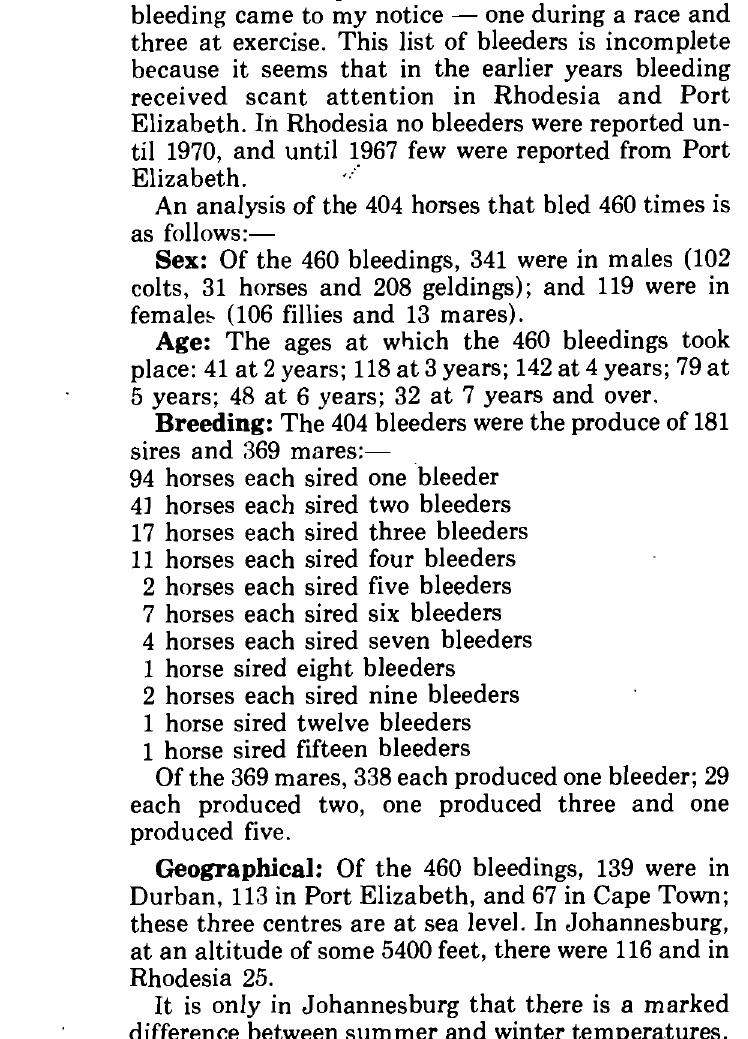
Table 1: DURATION OF SUSPENSION OF HORSE: DUE TO EPISTAXIS